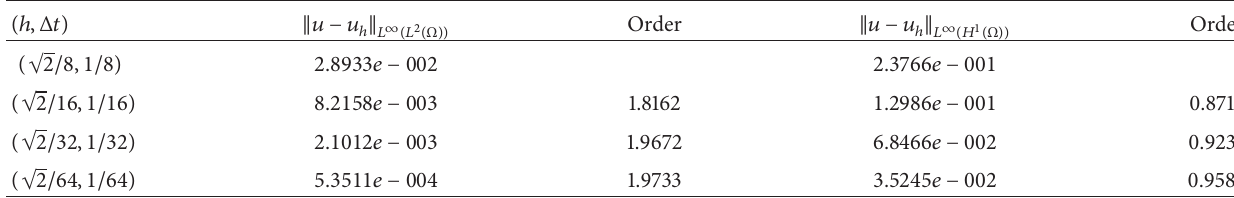
Table 1: 𝐿 2 and 𝐻 1 -norms and convergence order for 𝑢 .